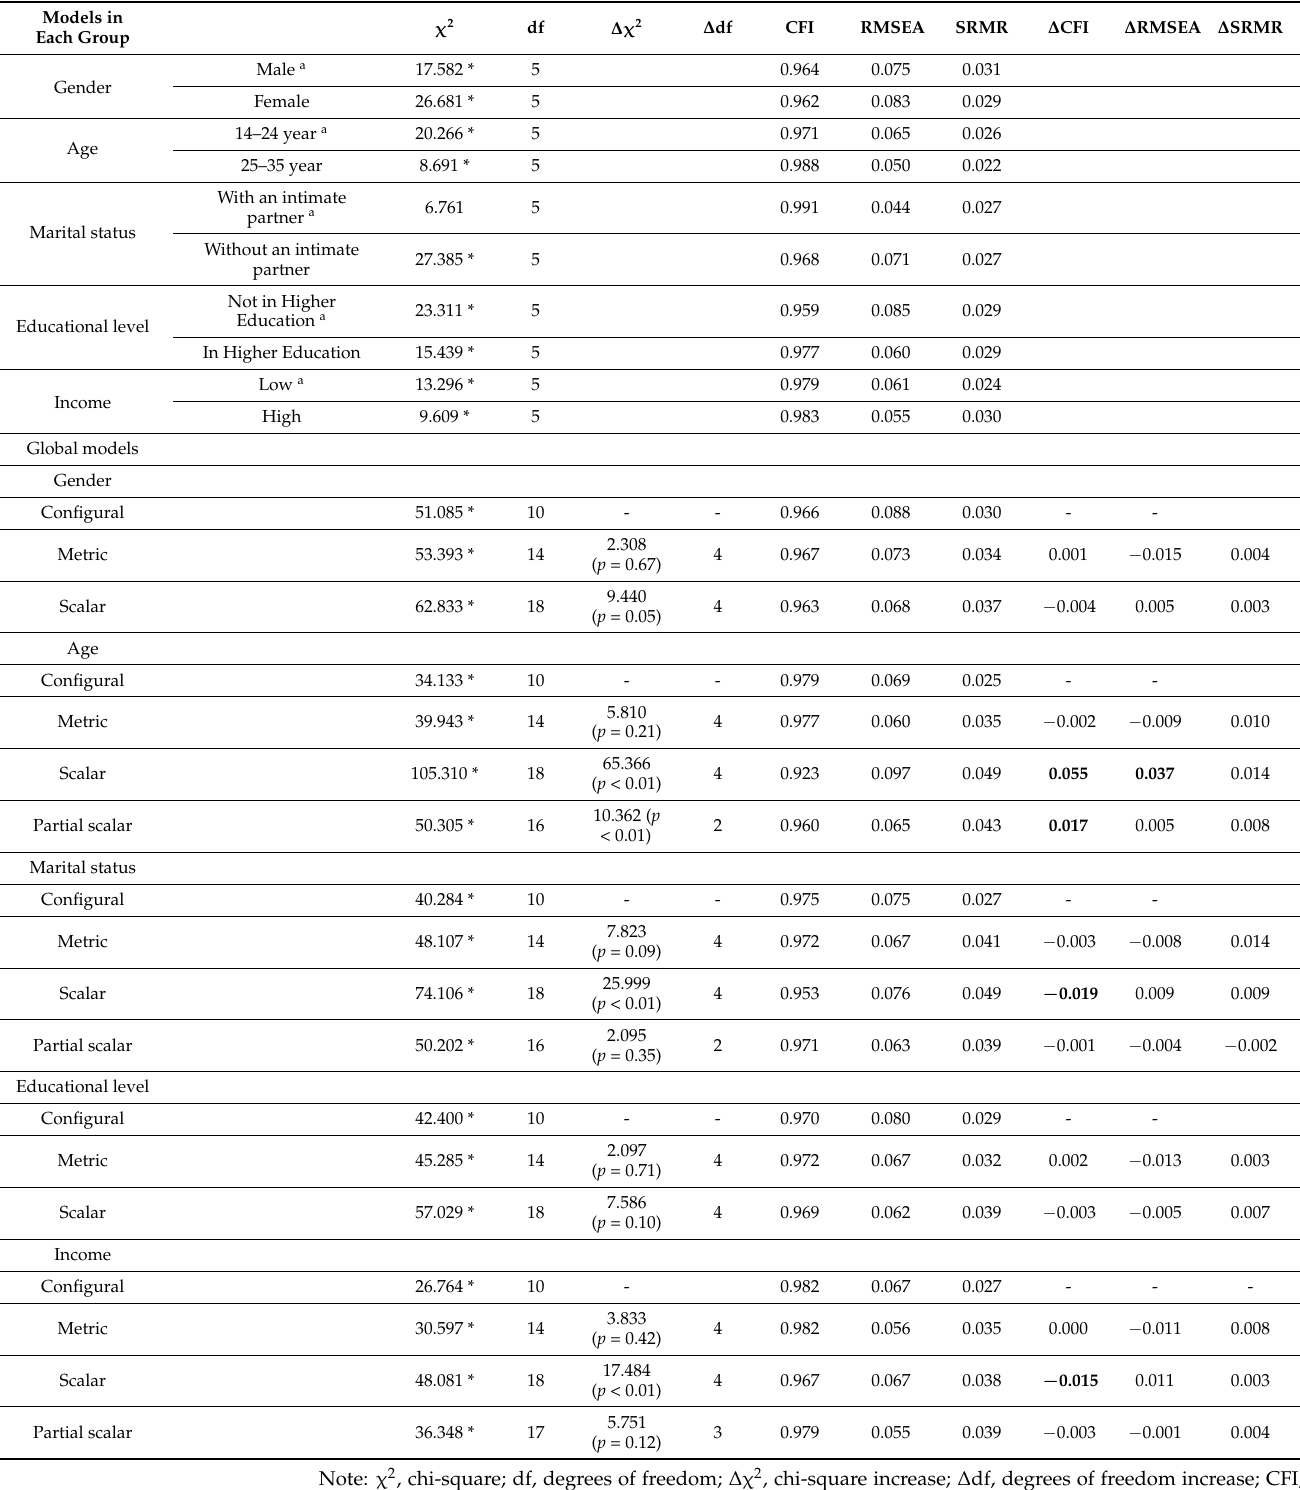
Table 3. Measurement invariance models of the Satisfaction with Life Scale